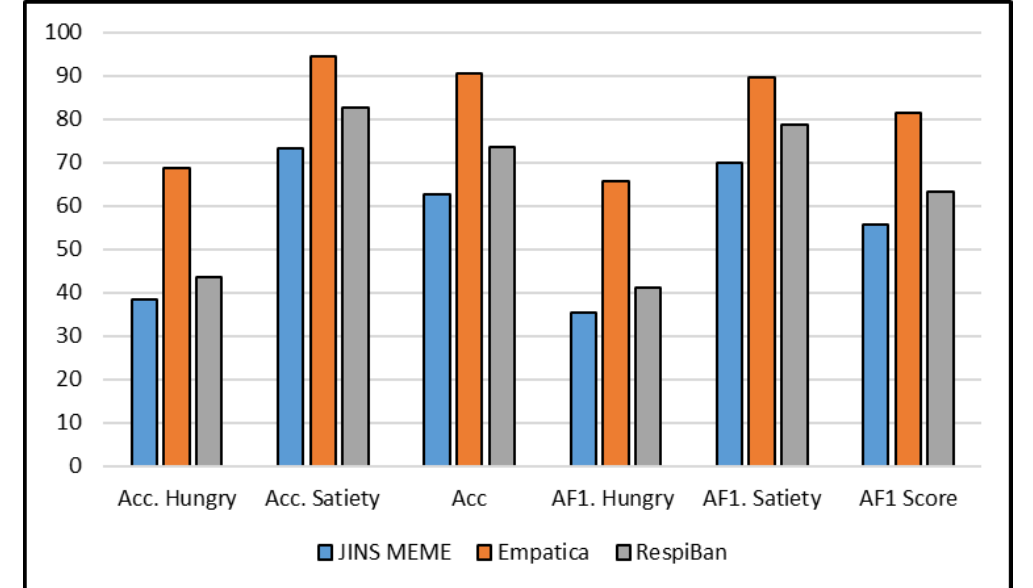
Figure 6. Comparison of sensor devices on the basis of accuracy (Acc) and averaged macro F1 score (AF1) for hungry and satiety classes. Empatica: Empatica E4 wristband; JIMS MEME: JINS MEME smart glasses; RespiBan: RespiBan professional device, including ECG, EMG, and EDA sensors.